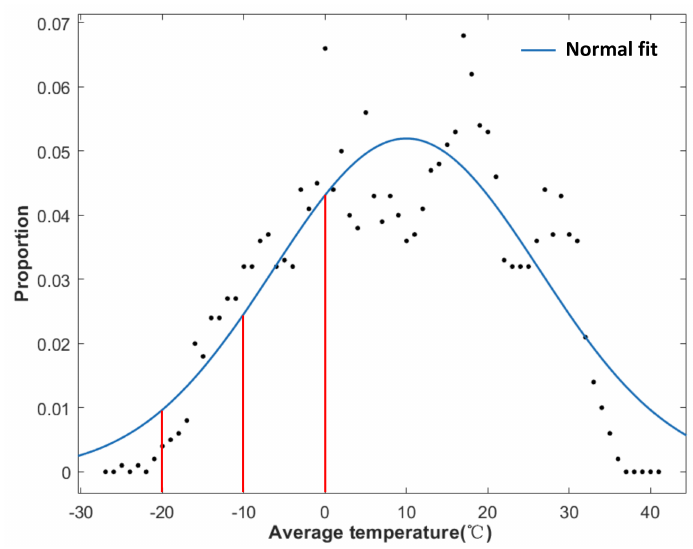
Figure 2. Normal fitting of average